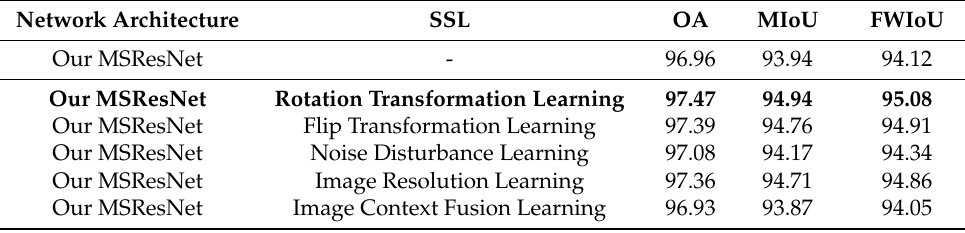
Table 2. Quantification of the effectiveness of our MSResNet via five SSL strategies on the GID dataset (%).